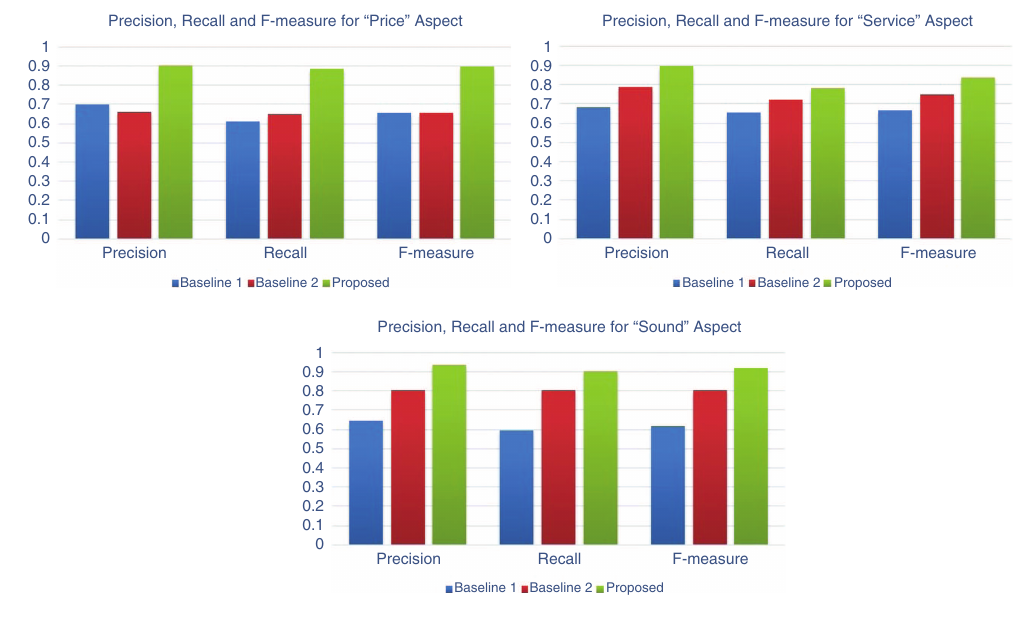
Figure 6: Graph Showing Precision, Recall, and f-Measure for Various Aspects. Table 6: Performance of our Proposed Aspect-Oriented Sentiment Analysis When Compared with Chosen Baselines [25, 19].